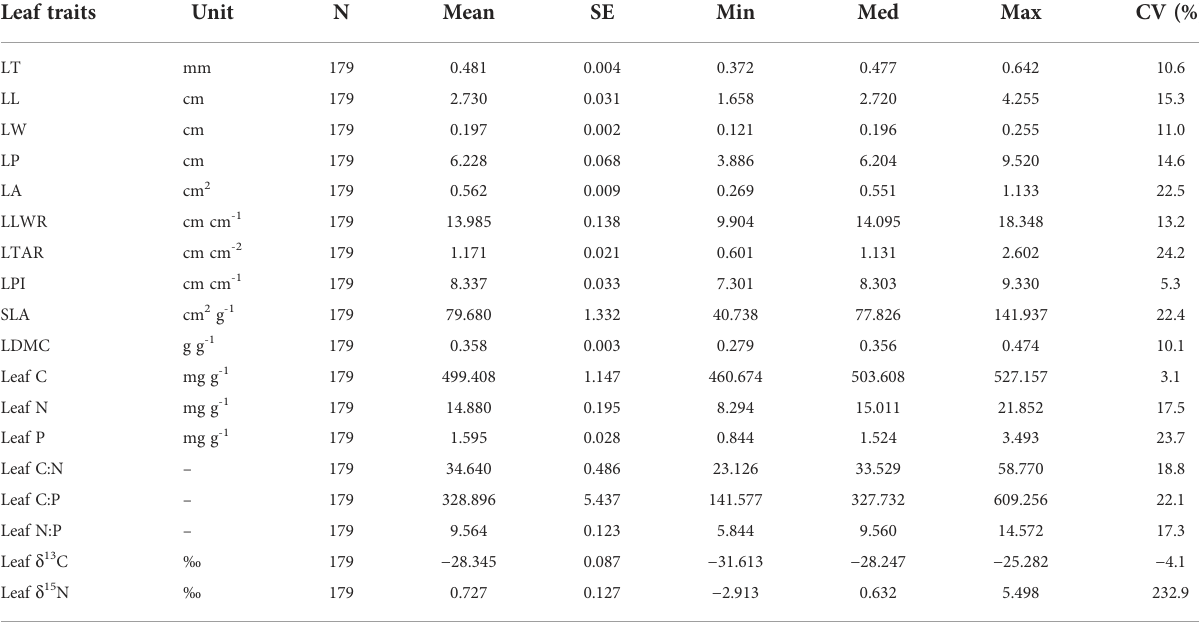
TABLE 1 Descriptive statistics of 18 leaf traits in T. fuana in six populations. Leaf